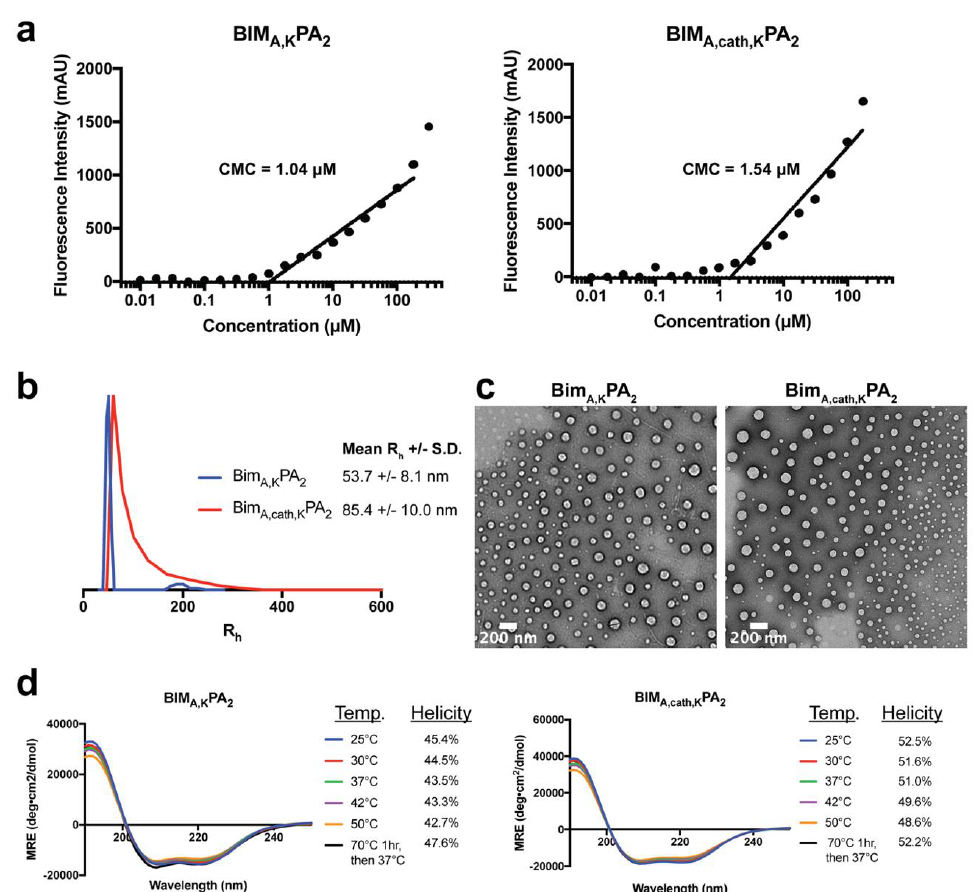
Figure 3. Biophysical characterization of peptide amphiphile (PA) self-assembly into micelles. ( a ) The critical micelle concentration (CMC) of BIM A,K PA 2 and BIM A,cath,K PA 2 as measured using 1,6-diphenyl-1,3,5-hexatriene (DPH) incorporation assay. ( b ) Dynamic light scattering (DLS) measurements of the hydrodynamic radii of BIM A,K PA 2 and BIM A,cath,K PA 2 indicated uniform micelle formation. ( c ) Negative-stained TEM confirmed that BIM A,K PA 2 and BIM A,cath,K PA 2 micelles were spherical and of equivalent sizes as measured by DLS. ( d ) Circular dichroism (CD) of the BIM BH3 peptide secondary structure within BIM A,K PA 2 and BIM A,cath,K PA 2 micelles revealed stable α -helicity of the BIM A peptides independent of temperature.